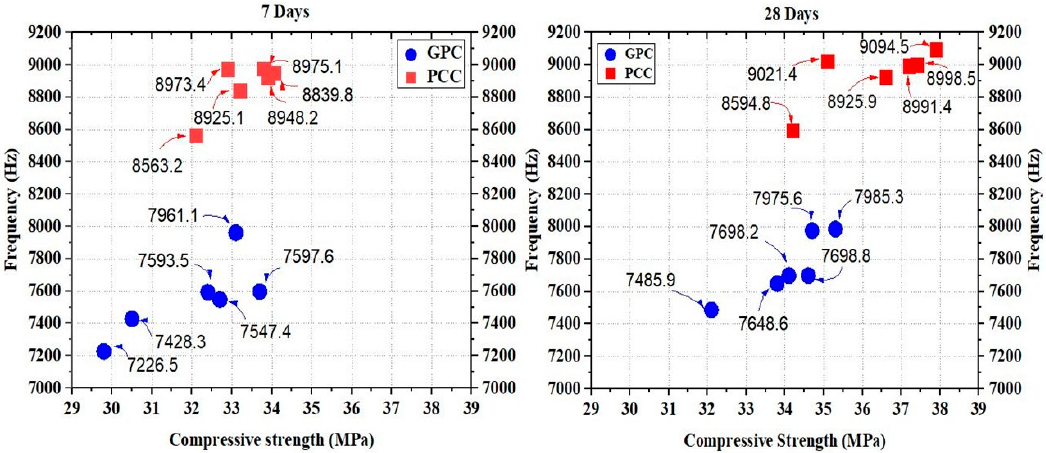
Figure 5. Compressive strength of GPC and Portland Cement Concrete (PCC) vs. Frequency.